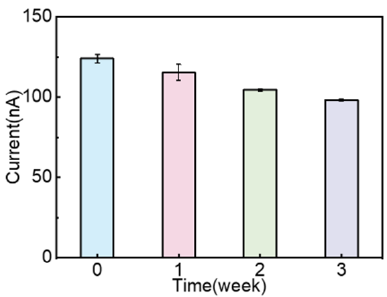
Figure 8. Stability verification stored in PBS at 4 °C in three weeks by differential pulse voltammetry (DPV) method.